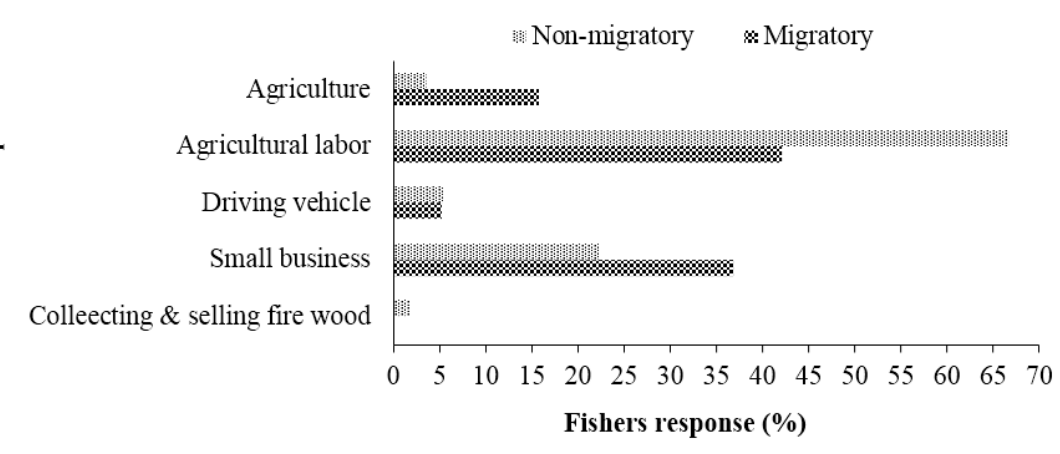
Figure 6. Livelihood diversification of the migratory and non-migratory fishers’ dependent on the Padma River fisheries, Bangladesh.